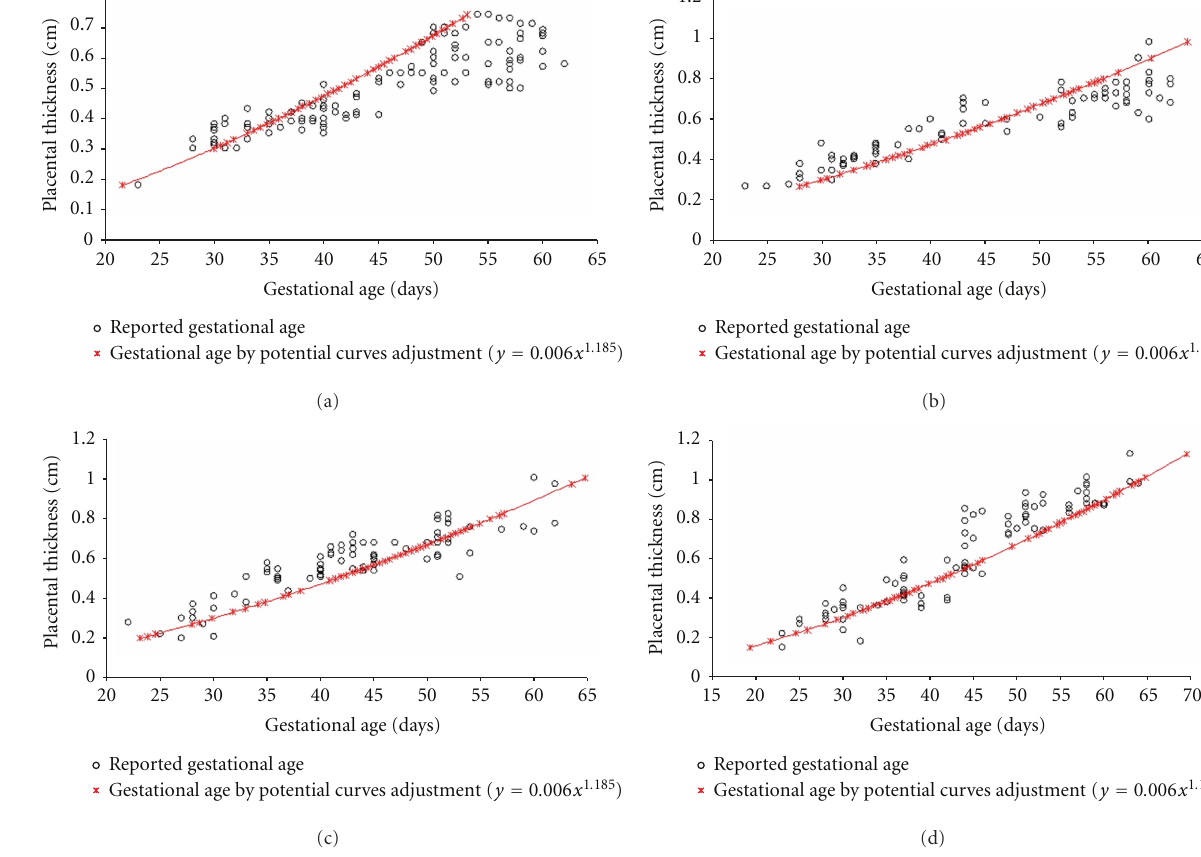
Figure 4: Scatter plot of the correlation between the gestational age defined by the potential adjustment and the reported age for the small ( y = 0 . 006 x 1 . 185 —(a)), medium ( y = 0 . 006 x 1 . 185—(b)), large ( y = 0 . 006 x 1 . 185 —(c)), and giant ( y = 0 . 006 x 1 . 185 —(d)) size breed.